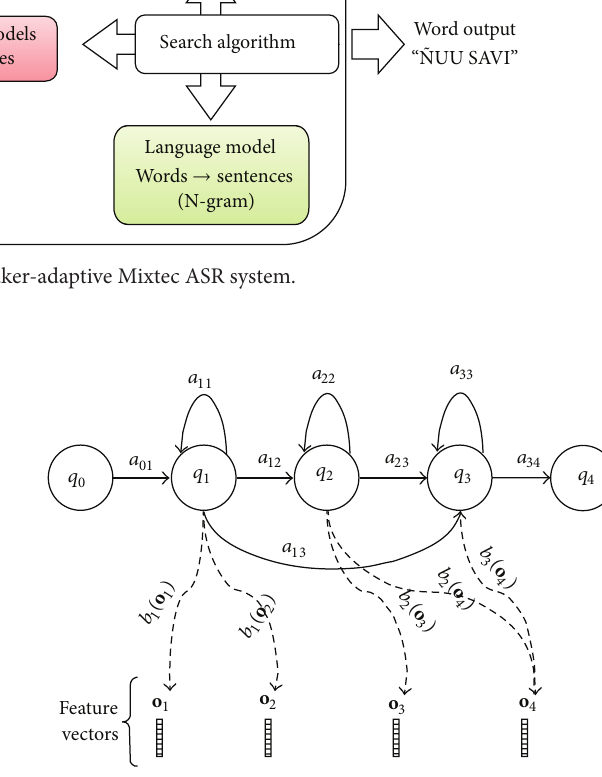
Figure 7: Three-state left-to-right topology of a phoneme